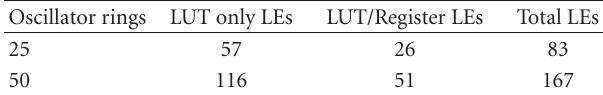
Table 1: Resources used in the Altera FPGA. Oscillator rings LUT only